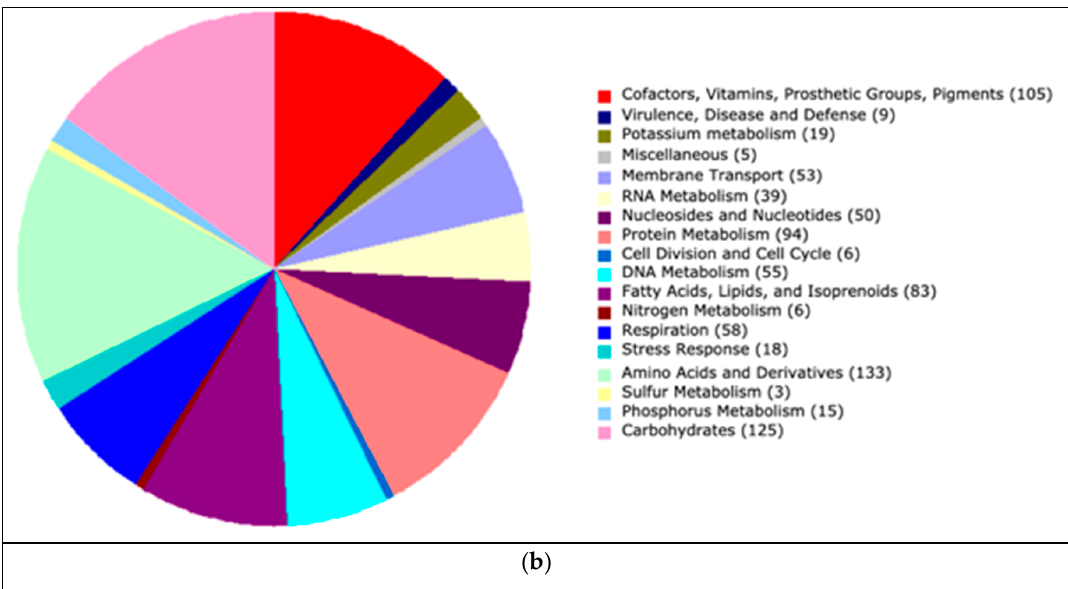
Figure 7. ( a ) Phylogeny for RC33 using amino acid identity. The scale represents change of amino acid substitution over time. ( b ) Subsystem category distribution for RC33. The graph represents the number of proteins that were grouped into a specific subsystems; 883 from a total 1570 coding sequences were identified to fit into subsystems. This chart was generated using Rapid Annotation System Technology (RAST).